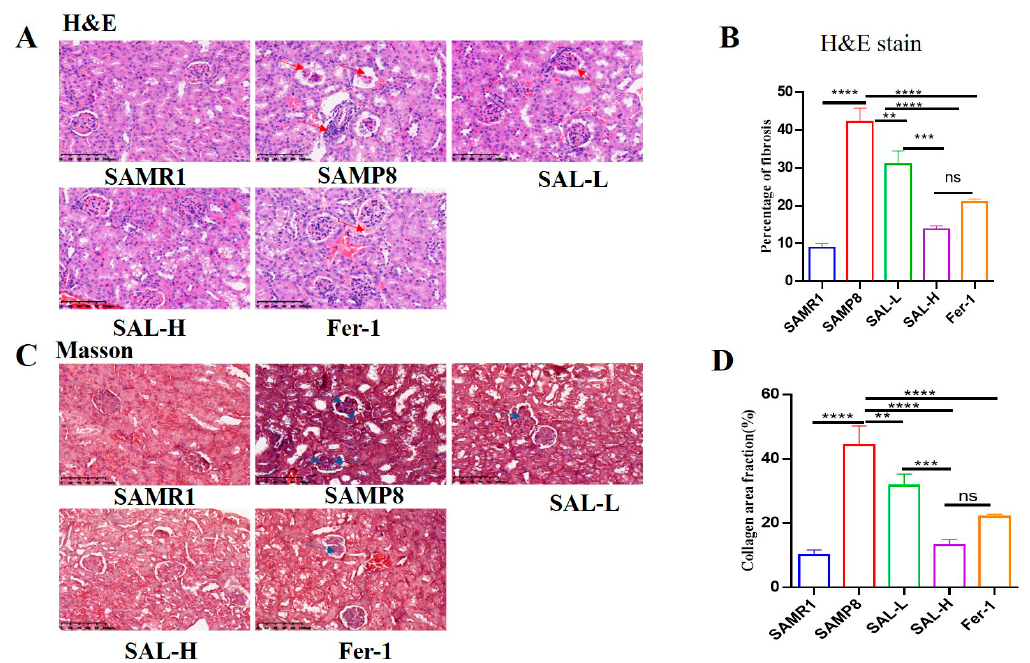
Figure 5. Effects of SAL on histopathological changes in the renal cortex in SAMP8 mice: hematoxylin– eosin (H&E) and Masson staining, 400 × . ( A , B ) The results of HE staining in the renal cortex. The arrows indicate the glomerular mesangial cells. ( C , D ) The results of Masson staining in the renal cortex. The arrows indicate glycoprotein deposition. Data are expressed as means ± SD, * p < 0.05, ** p < 0.01, *** p < 0.001, **** p < 0.0001.